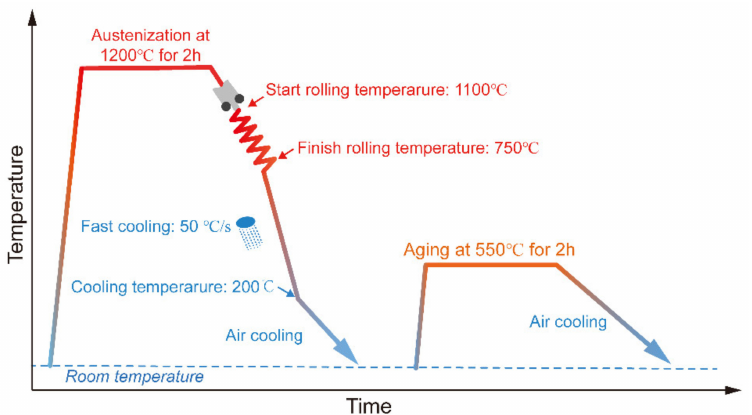
Figure 1. Schematic illustration of the TMCP and aging process for the experimental